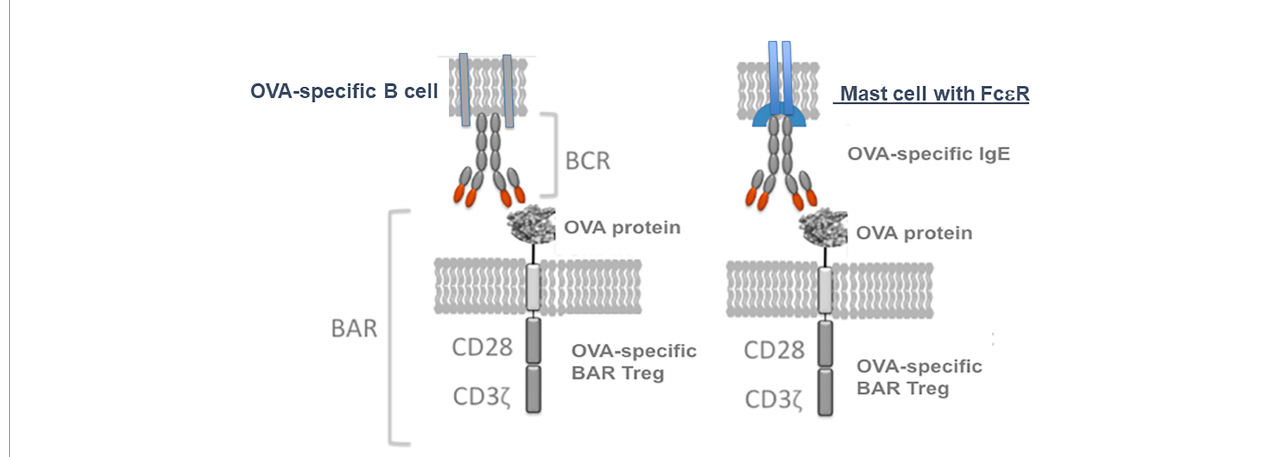
FIGURE 3 | Model for BAR Tregs interaction not only with the immunoglobulin receptor on B cells, but also Ig(E) bound via Fc e R on mast cells. Tregs expressing an antigen like ovalbumin (OVA) can interact with either speci fi c B cell IgM (left, the BCR) or IgE bound to mast cells (right, in sensitized